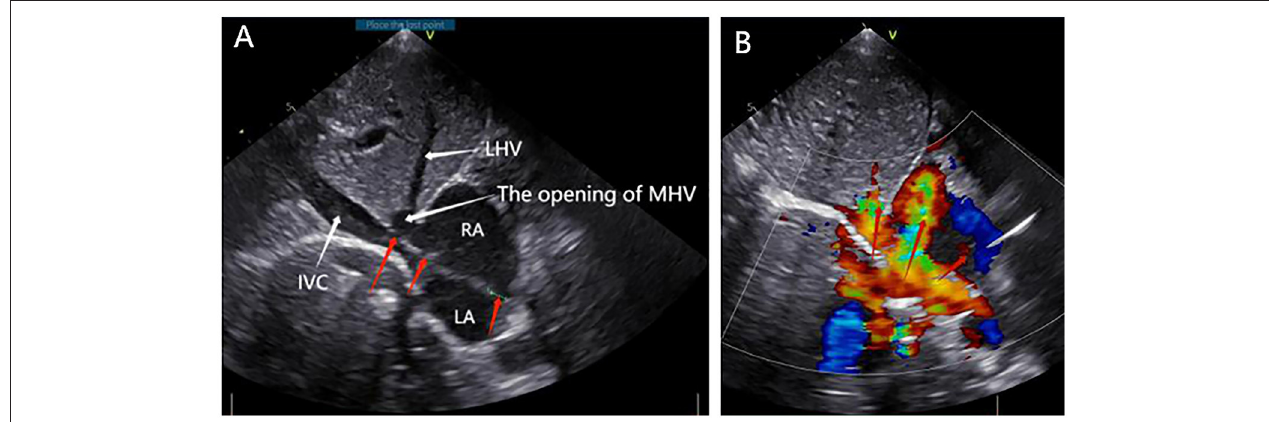
FIGURE 1 | Preoperative transthoracic echocardiography. (A) Right atrium (RA), left atrium (LA), left hepatic vein (LHV), the opening of middle hepatic vein (MHV), inferior vena cava (IVC) (white arrowheads), and three atrial septal defects (ASD) (red arrowheads). (B) Blood flowed from the left atrium to the right atrium (red